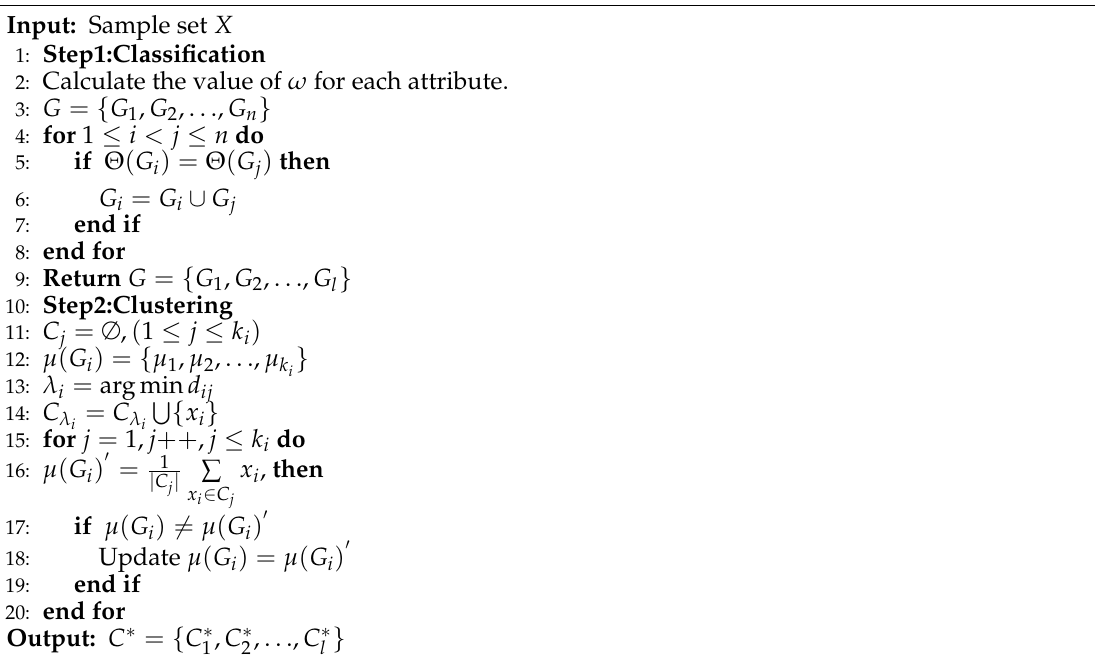
Algorithm 1 Virtual sensor provisioning